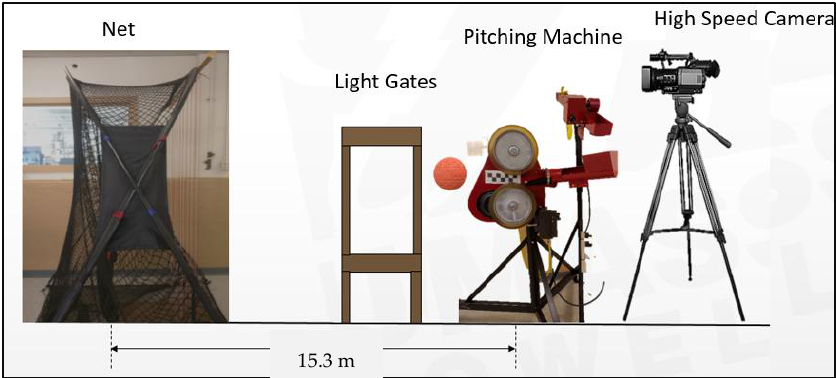
Figure 2. Schematic of the test set-up for long-range study to investigate ball inconsistency.